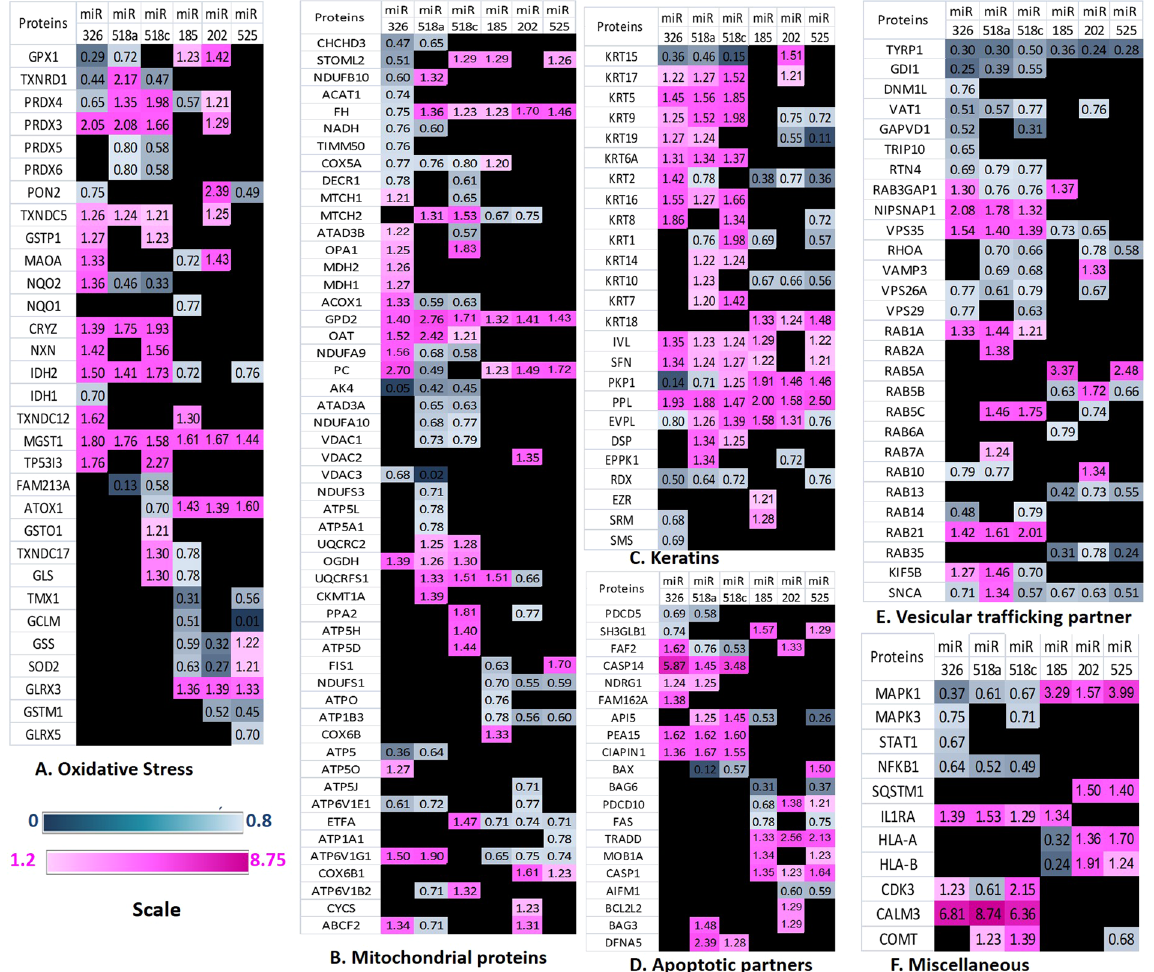
Figure 2. Heat Map of proteins regulated in keratinocytes after transfection with different miRNAs as revealed by iTRAQ mass spectrometry. Proteins have been grouped into different networks and their relative expressions at protein level are depicted where fold change of ≤ 0.8 is shown as downregulated in blue colour and fold change ≥ 1.2 is shown as upregulated in pink colour. ( A ) Oxidative stress Proteins; ( B ) Mitochondrial proteins; ( C ) Keratins & Structural proteins; ( D ) Apoptosis proteins; ( E ) Vesicular trafficking partners; ( F ) Miscellaneous protein including Immune System proteins & related